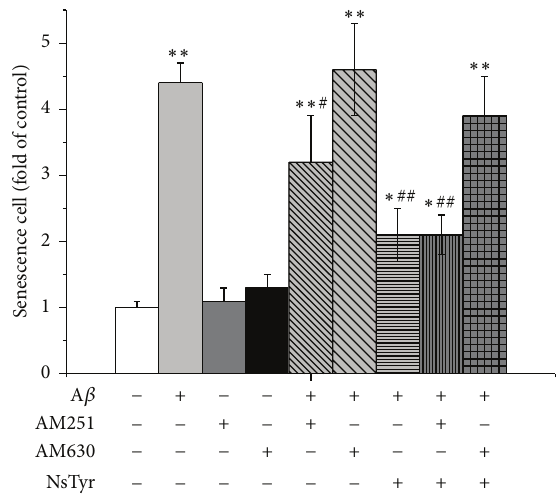
Figure 8: The effects of selective receptor antagonist on the number of senescence cells. The NSPCs were treated with (1) none, (2) , (3) AM251, (4) AM630, (5) A 𝛽 1 A 𝛽 1 – 42 + NsTyr-2K, (8) A 𝛽 1 AM630, (7) A 𝛽 1 – 42 + AM630 + NsTyr-2K. ∗ 𝑃 < 0.05 , ∗∗ 𝑃 < 0.01 versus and (9) A 𝛽 1 – 42 control group. # 𝑃 < 0.05 , ## 𝑃 < 0.01 versus A 𝛽 1